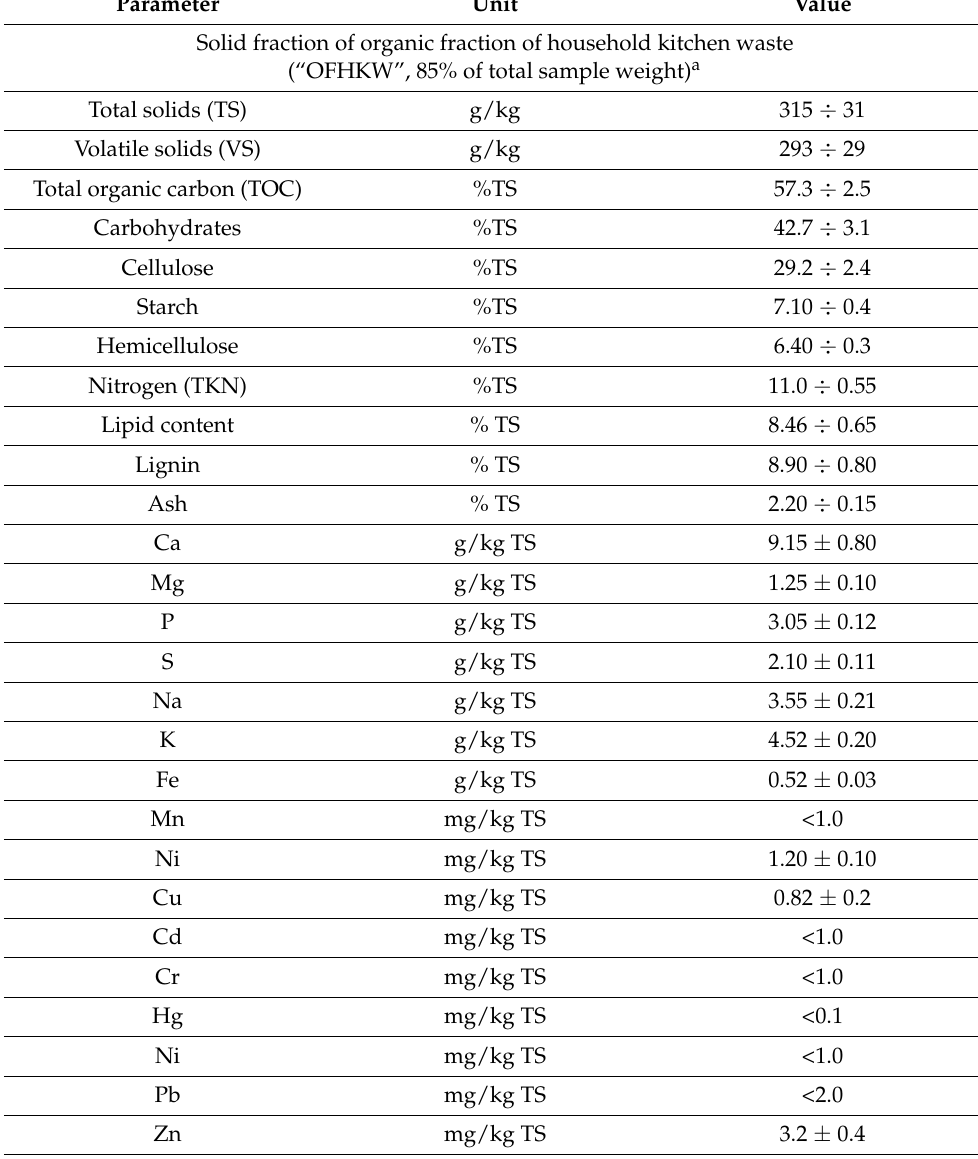
Table 1. Characterization of OFHKW (organic fraction of household kitchen waste) used in the current study (average values n = 3, ± standard